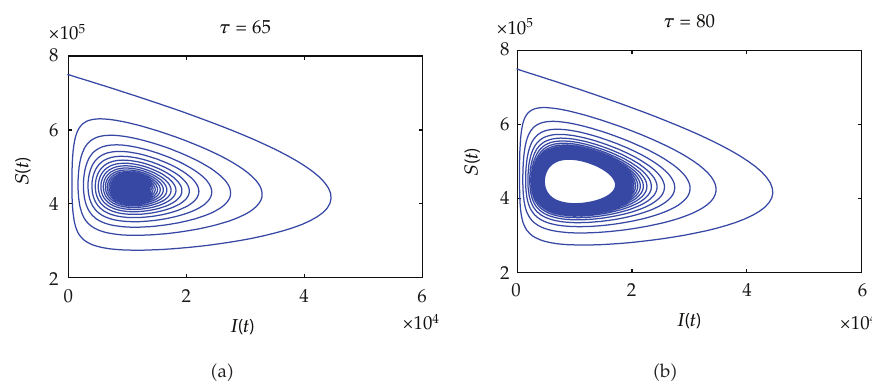
Figure 8: The phase portrait of susceptible hosts S (cid:5) t (cid:6) and infectious hosts I (cid:5) t (cid:6)